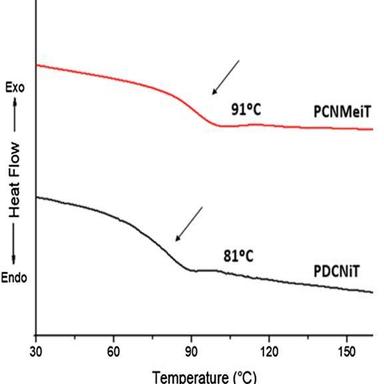
DSC thermograms for both poly(itaconate)s, with Tg values pointed by black arrows.